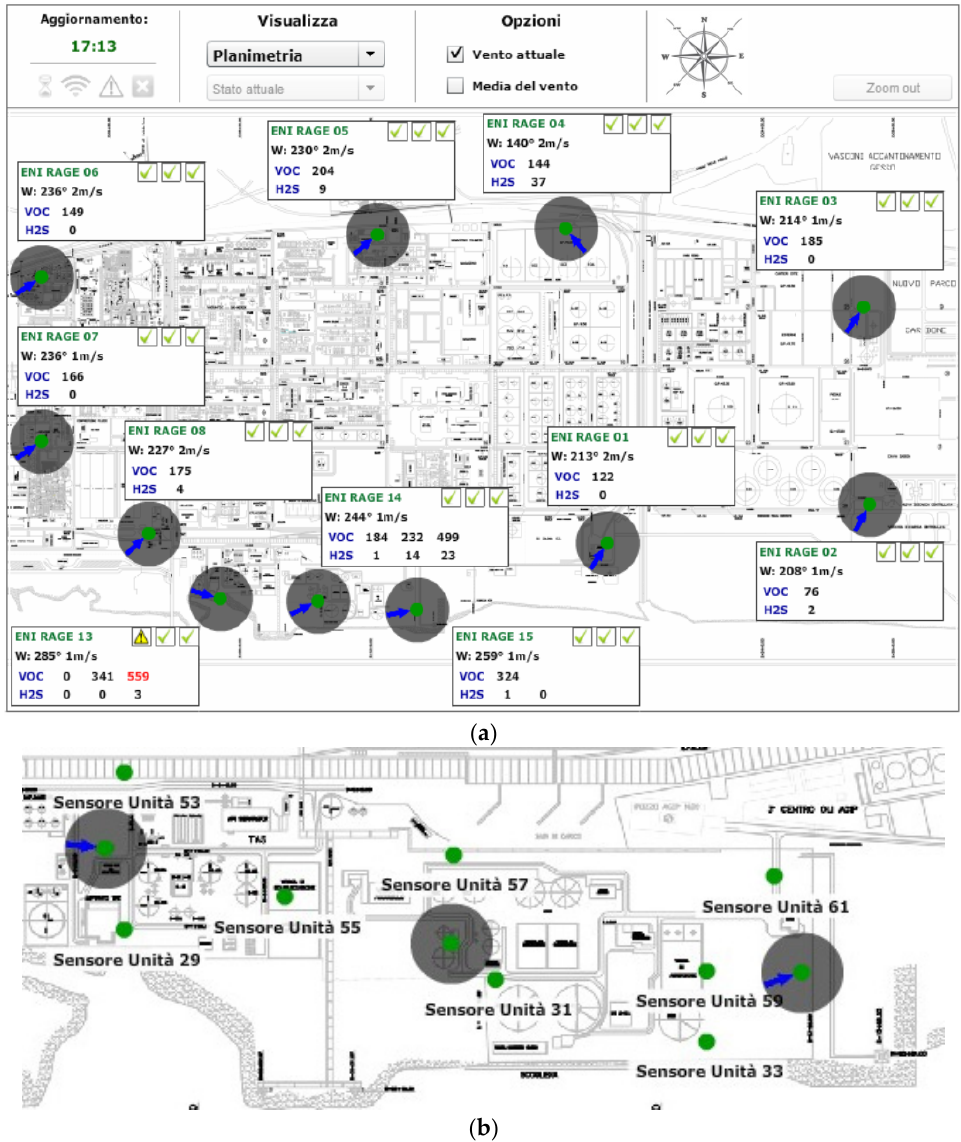
Figure 1. ( a ) layout of the RAGE installation; ( b ) close-up of SNU and end node units (ENU) deployment around the wastewater treatment plant.